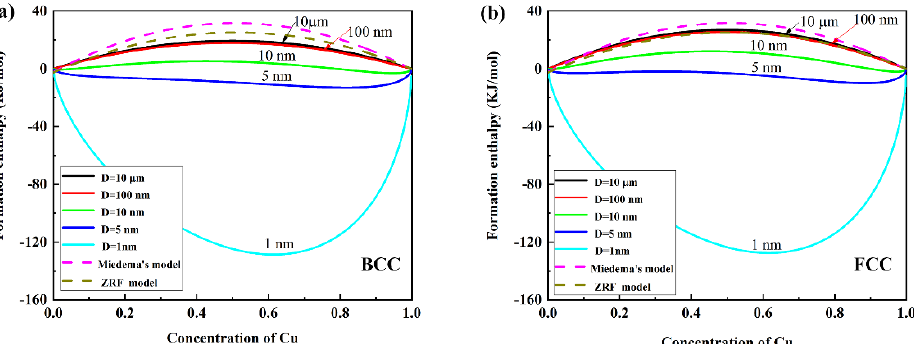
Figure 2. Formation enthalpy of W–Cu system as the function of Cu concentration at different particle sizes. ( a ) BCC crystalline structure, ( b ) FCC crystalline structure. E bW = − 336 kJ mol − 1 , E bCu = − 824 kJ mol − 1 , d W = 0.278 nm, d Cu = 0.2556 nm; all the data are taken from Reference [24].